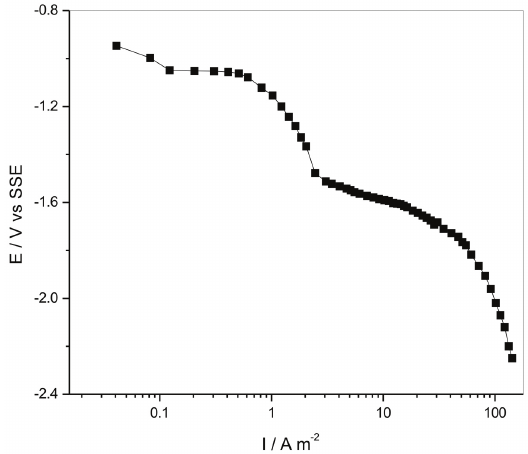
Figure 2. Cathodic galvanostatic polarization curves of the steel substrate in Bath 5 of Table 1.